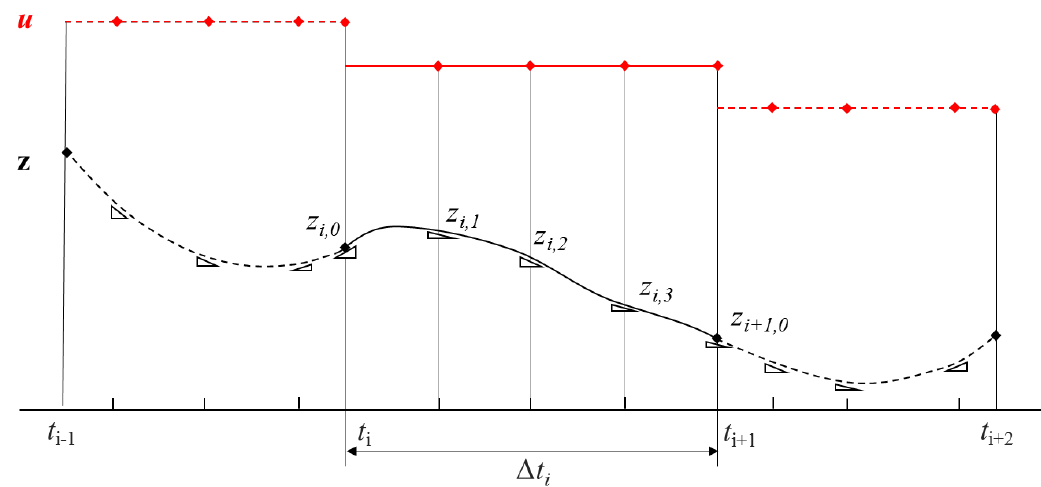
Figure 6. Collocation method for state and control profiles (based on Biegler, 2007 [44]).